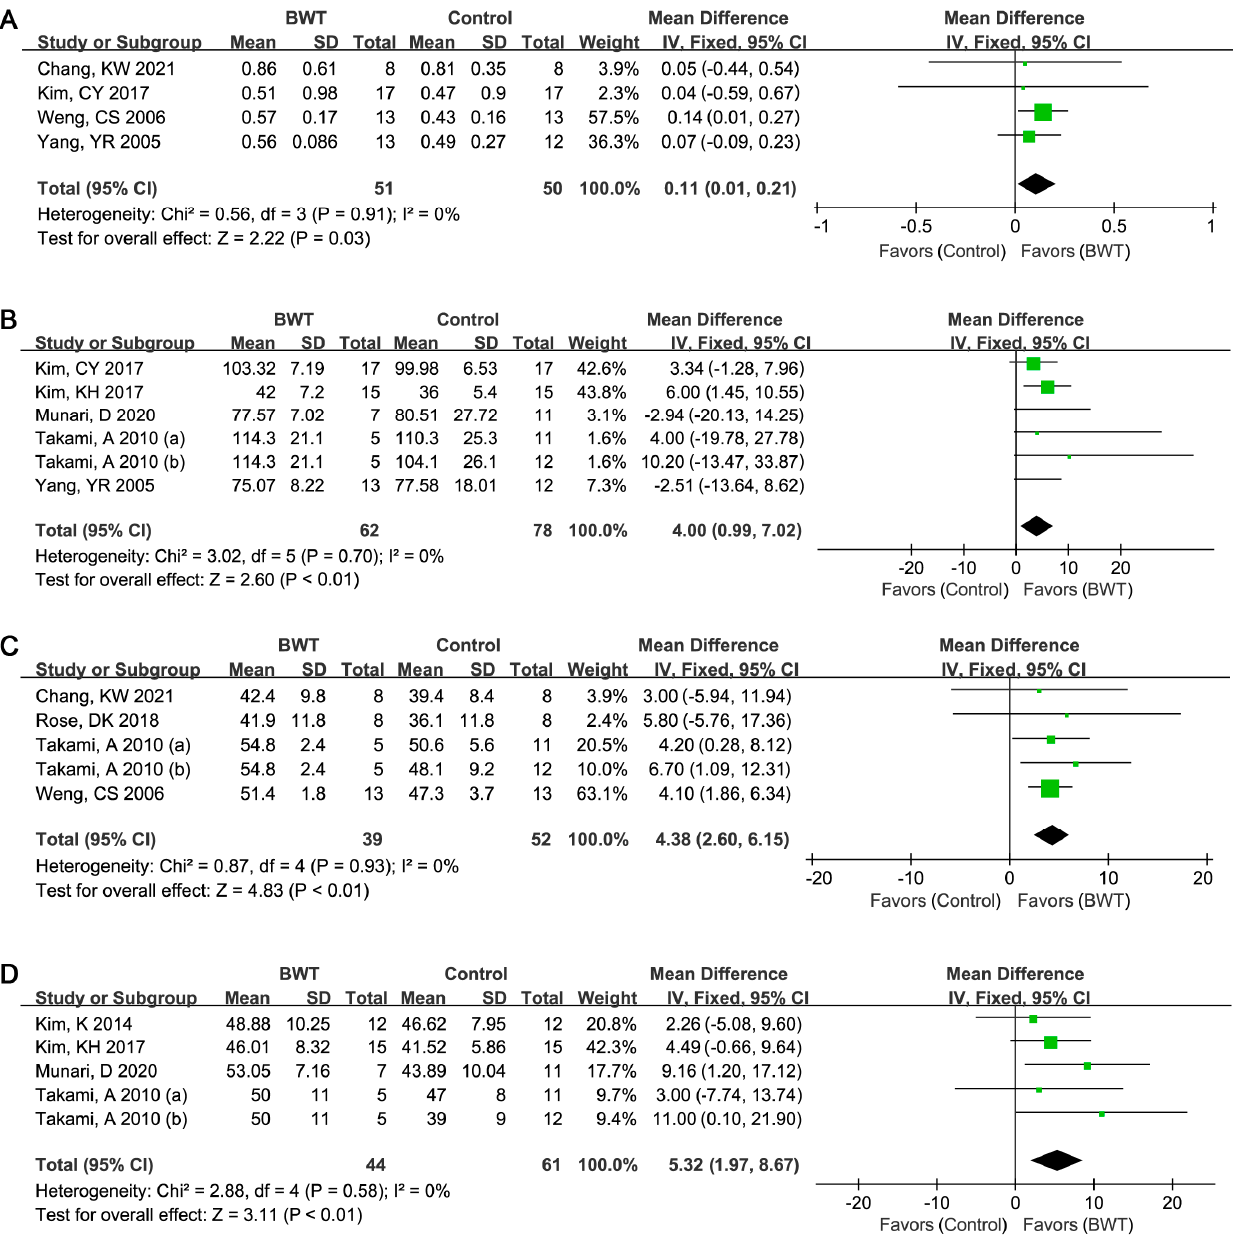
Figure 3. Forest plot for meta-analyzing the role of backward walking training and conventional treatment on 10-Meter Walk Test (10MWT), cadence, Berg balance scale (BBS), and paretic step length. ( A ): 10MWT; ( B ): cadence; ( C ): BBS; ( D ): paretic step length.